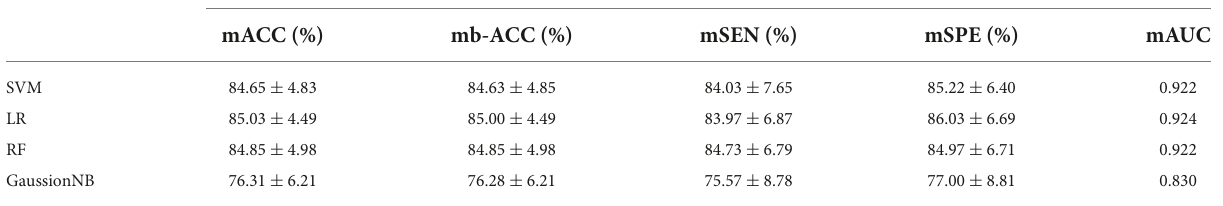
TABLE 2 Classification performance of multiple classifiers in the testing dataset. Model Testing